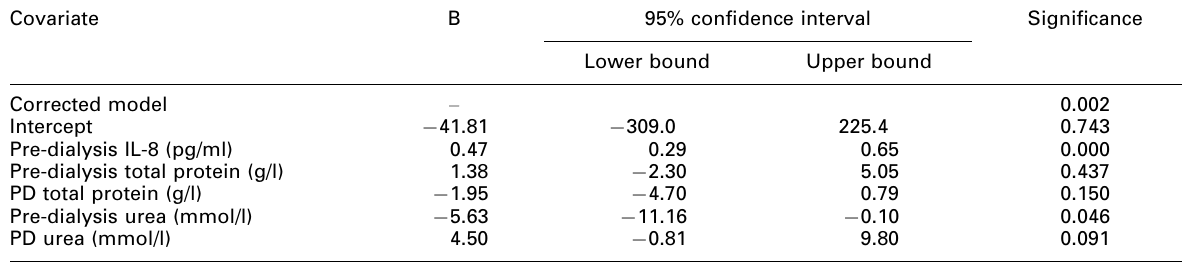
Table 2. Univariate linear regression analysis, paired difference (PD) (pre-hemodialysis minus post-hemodialysis values) of IL- 8 levels as the dependent variable Covariate B 95% confidence interval Significance Lower bound Upper bound Corrected